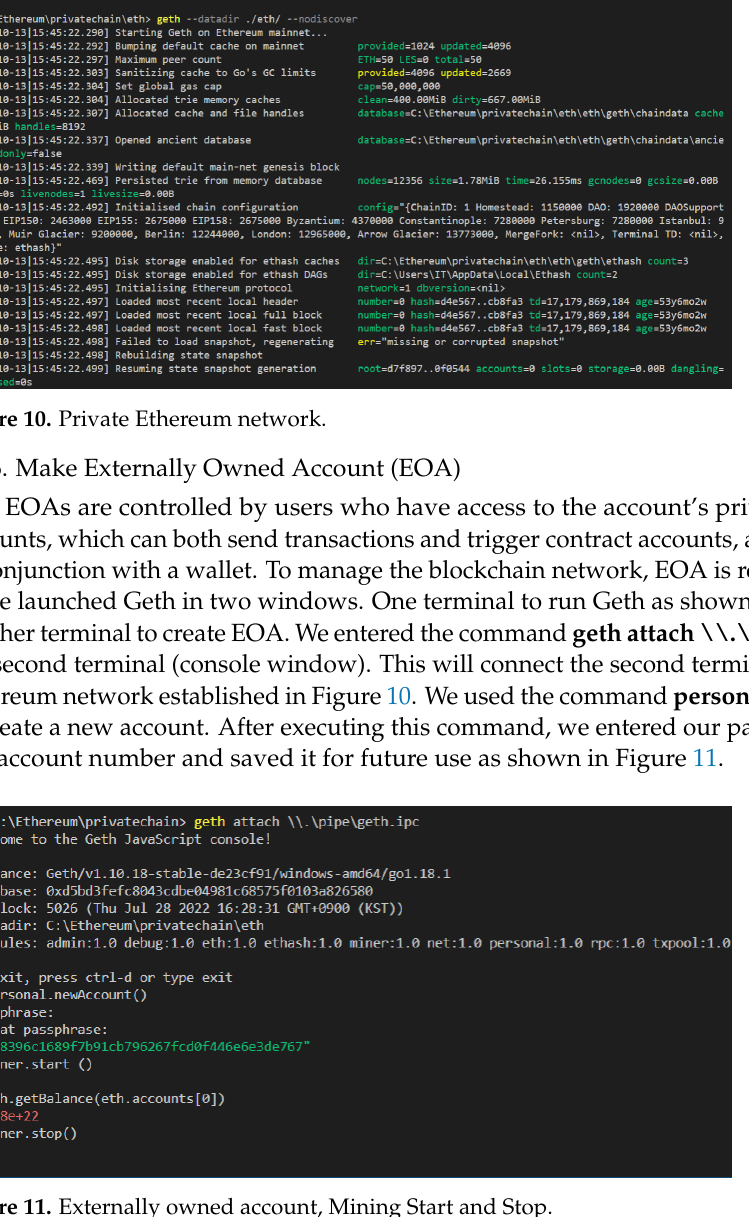
Figure 11. Externally owned account, Mining Start and